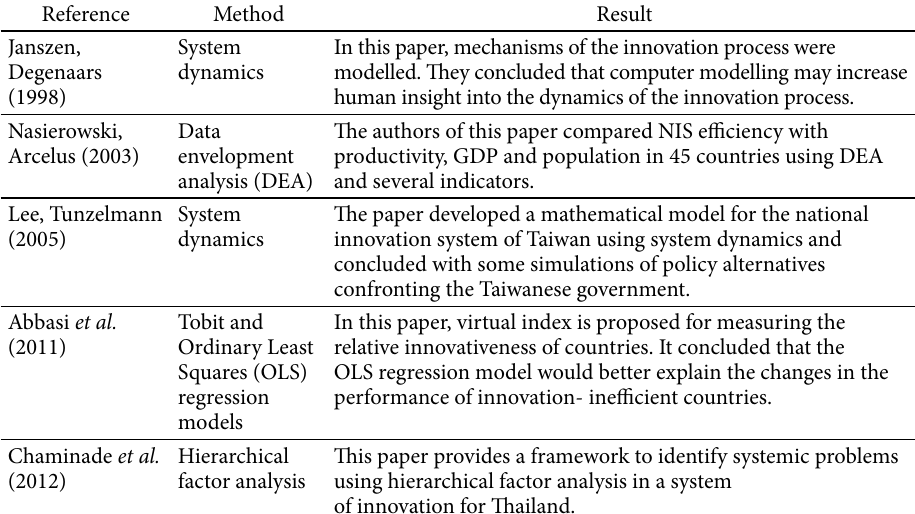
Table 1. Some methods for assessing and improving the innovation system